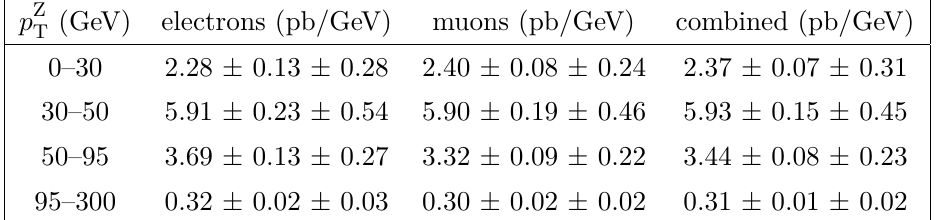
Table 7 . Measured differential cross section as a function of p Z and combined value. The first and second uncertainty values correspond to the statistical and systematic contributions,